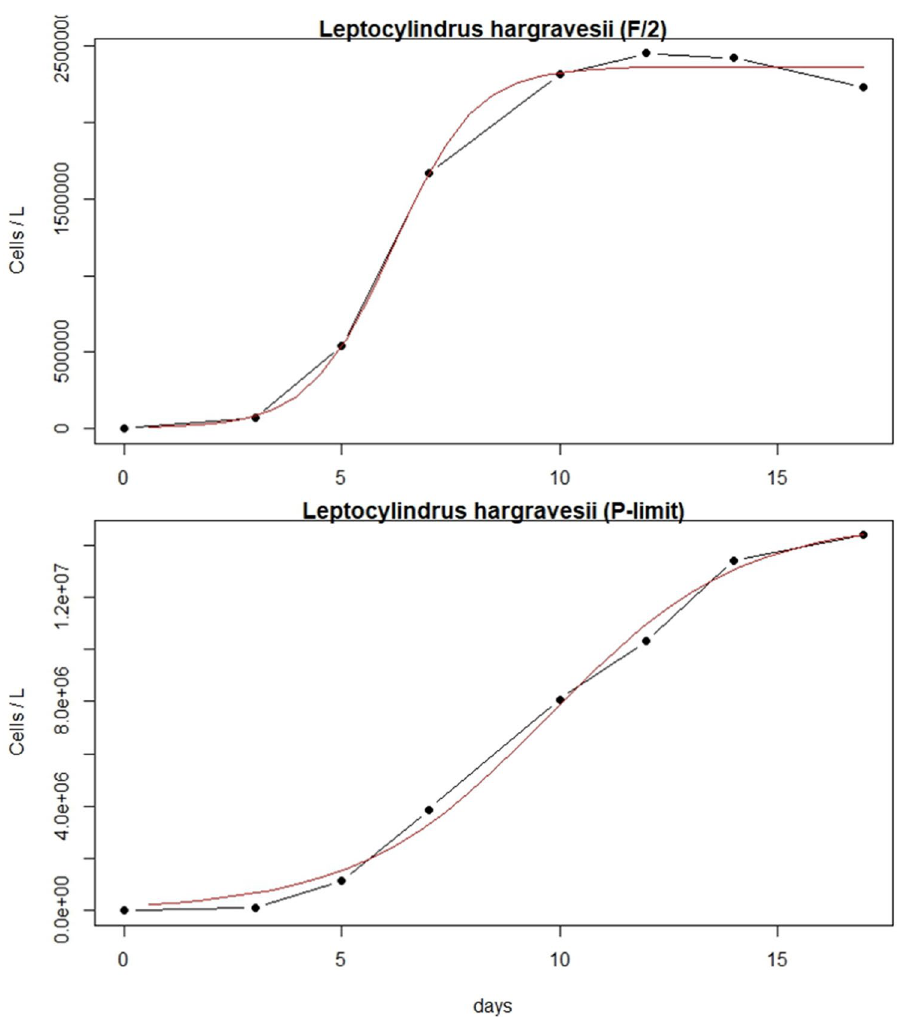
Figure 6. Growth curves of L. hargravesii : averaged cell concentrations in F/2 and P-limit medium throughout 14 days of experiment